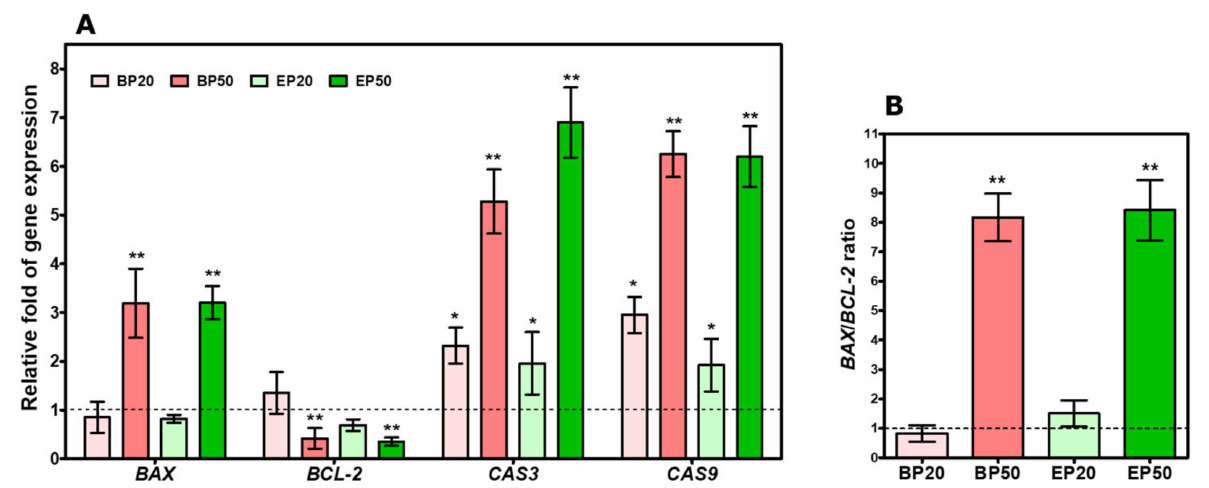
Figure 7. Effect of BP and EP on apoptotic gene expression of HEp2 cell line after 48 h treatment. ( A ) Expression profile of BAX, BCL-2, CASPASE-3, and CASPASE-9 mRNA (normalized with GAPDH ). ( B ) BAX/BCL2 ratio increased with BP50 and EP50 treatment. The thin horizontal line represents the normalization of the control. The results are expressed as mean ± SD of triplicate experiments. * p < 0.05, ** p < 0.01 significance difference between the control and